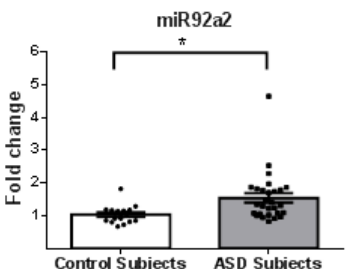
Figure 3. Scatter plot of differential relative expression of miR92a2 in peripheral blood of ASD subjects compared to control subjects. Results expressed as mean ± standard error. t -Test analysis; * p < 0.05. miR92a2 does not have validated targets in Homo sapiens.